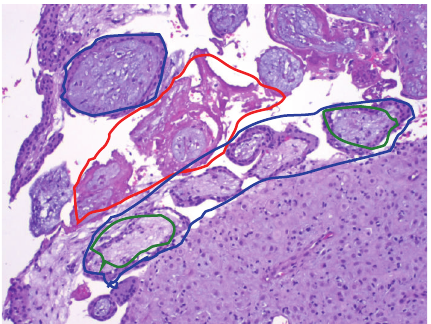
Figure 4: Pathology for patient 2. Specimen 1: endometrium and product of conception (POC) from D&E for VTOP. Green circles: decidua and chorionic villi with viable syncytiotrophoblast; blue circles (purple color): degenerating villi; red circles (pink color): fibrin or degenerated